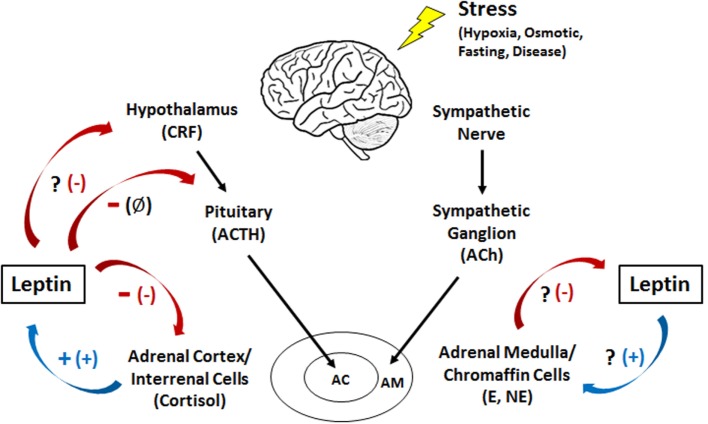
Interactions between leptin and the humoral adrenergic and hypothalamic–pituitary–adrenal/interrenal axes in teleosts and mammals. +, stimulation; -, inhibition; Ø, no effect; ?, an unknown relationship. The mammalian response is represented by the symbol in parentheses. CRF, corticotropin-releasing factor; ACTH, adrenocorticotropic hormone; Ach, acetylcholine; E, epinephrine; NE, norepinephrine; AC, adrenal cortex; AM, adrenal medulla.